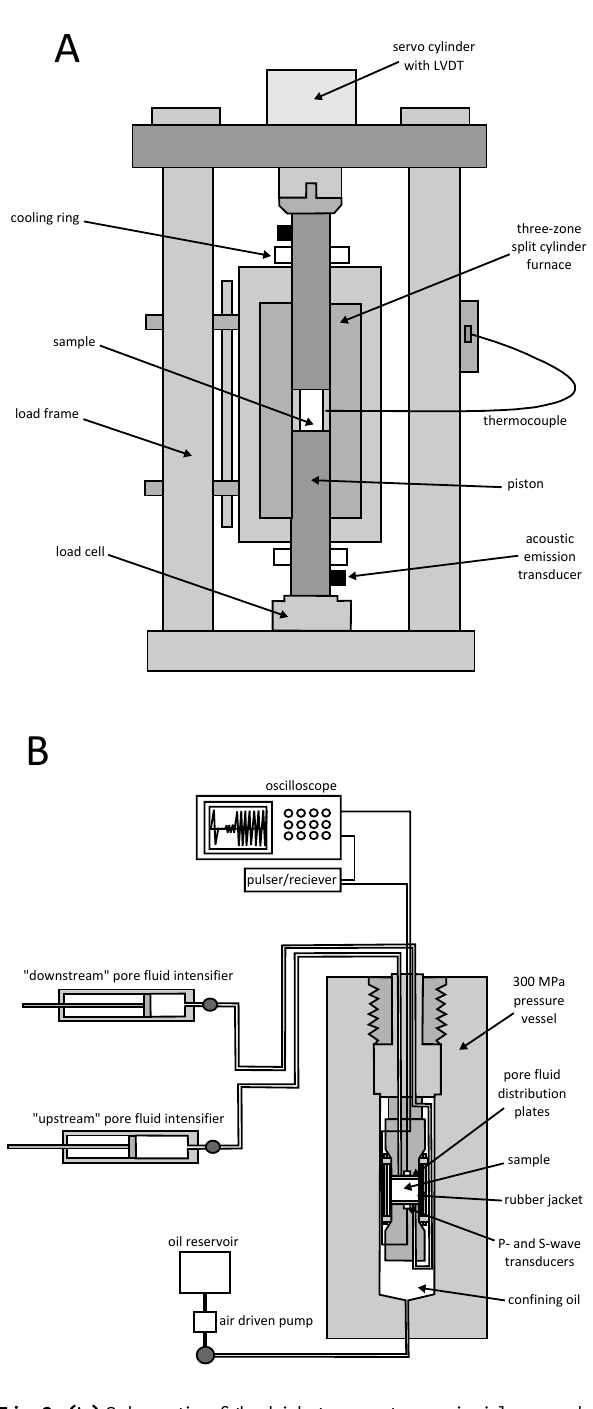
Fig. 2. (A) Schematic of the high temperature uniaxial press, de- scribed in detail by (Hess et al., 2007), at the Ludwig-Maximilians University in Munich (LMU). (B) Schematic of the 300MPa hydro- static pressure vessel equipped with two 70MPa servo-controlled pore fluid intensifiers or volumometers located in the Rock & Ice Physics Laboratory (RIPL) at University College London